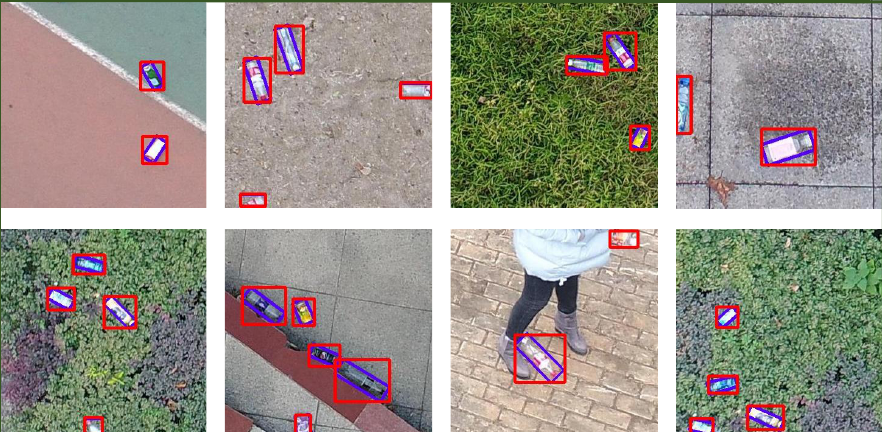
Figure 9. Detection results of the proposed detection algorithm in UAV-BD dataset. We demonstrate results in subfigures with varied backgrounds like grassland, playground and ground surface. Noticed that our algorithm could give the common bounding box in red and oriented bounding box in blue at the same time.